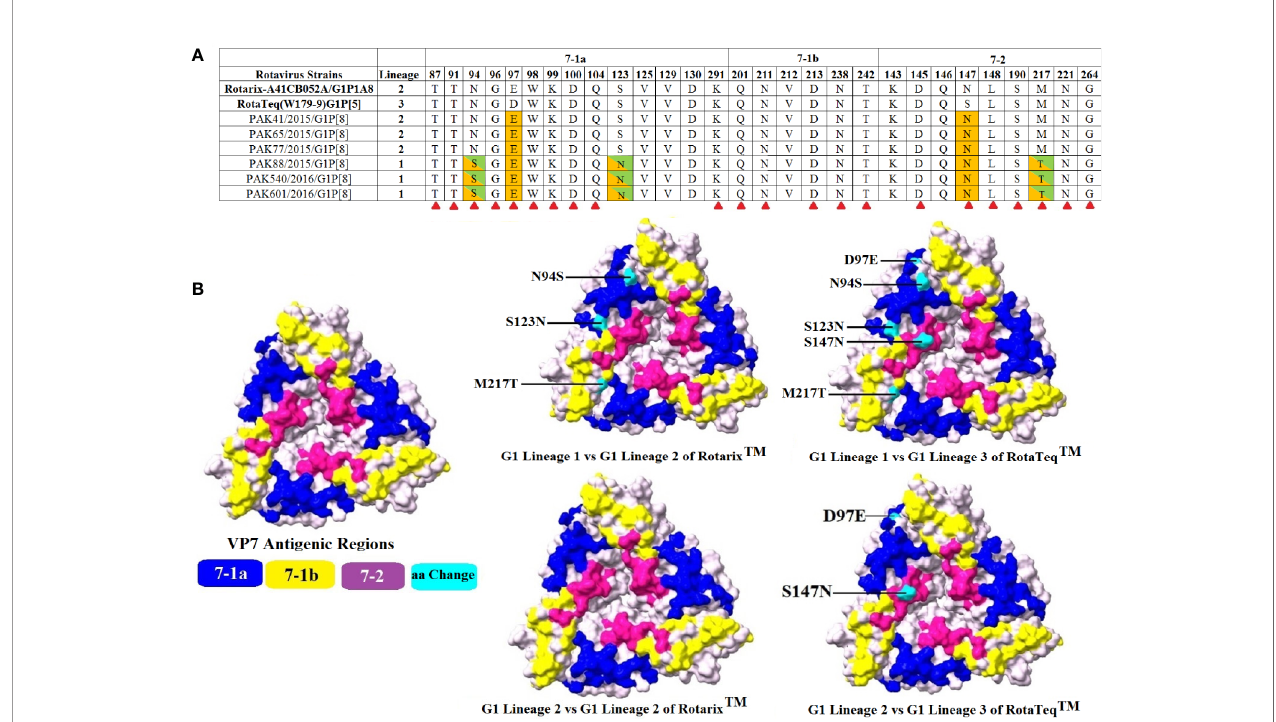
FIGURE 4 | Alignment of the antigenic epitopes of VP7-G1 of the Pakistani group A rotavirus (RVAs) with those of Rotarix ™ and RotaTeq ™ vaccines. (A) The whole antigenic region is divided into three epitopes 7-1a, 7-1b, and 7-2. Amino acid residues highlighted in green/orange colours are those different from both Rotarix ™ and RotaTeq ™ , amino acid residues different from Rotarix ™ and RotaTeq ™ are marked with green and orange colours, respectively and amino acid residues believed to induce escape from the mAbs neutralization are marked with red triangle (40). (B) Surface representation of VP7 trimer (PDB 3FMG). Antigenic epitopes 7-1a, 7-1b, and 7-2 are marked in blue, yellow and purple colours, respectively. Cyan colour shows surface exposed residues which differ between our G1 strains and vaccine